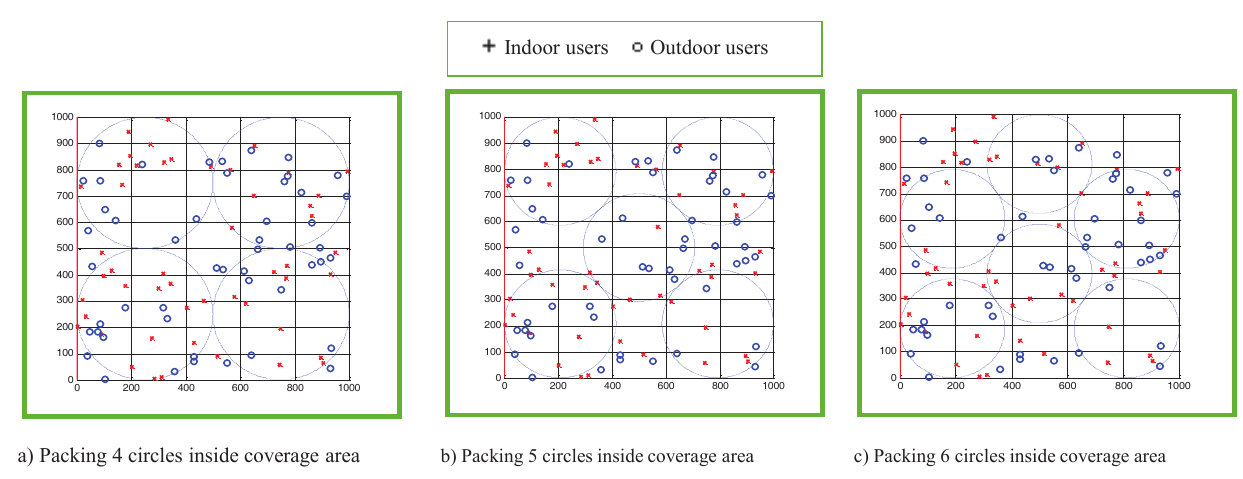
Figure 9. Optimal packing of ( a ) 4 circles, ( b ) 5 circles and ( c ) 6 circles using CPT inside a square region. Packing four, five and six circles into the coverage area, S , that has a square shape resulted in coverage density of 78.5%, 67.4% and 66.4%, respectively. Thus, the maximum achievable coverage density of packing n c equal circles in the coverage region is 78.5%, when n c = 4.